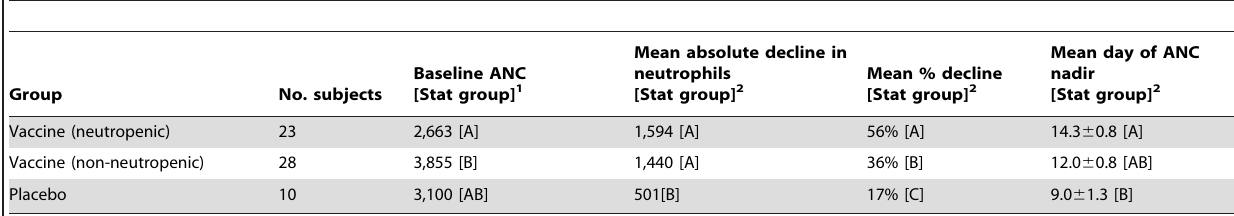
Table 2. Absolute neutrophil counts (ANC) in neutropenic rDEN1?30 vaccinees, non-neutropenic rDEN1 D 30 vaccinees, and placebo recipients following a single dose of